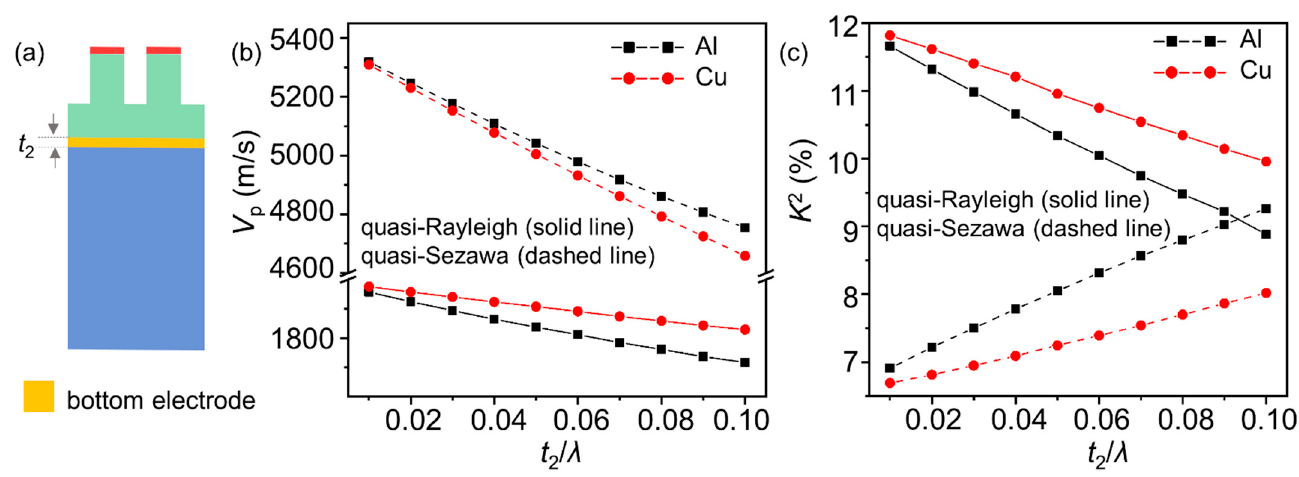
Figure 7. V p ( b ) and K 2 ( c ) of quasi-Rayleigh wave and quasi-Sezawa as functions of bottom electrode material and thickness t 2 / λ based on the partially etched ZnO/metal/SiC structure ( a ).